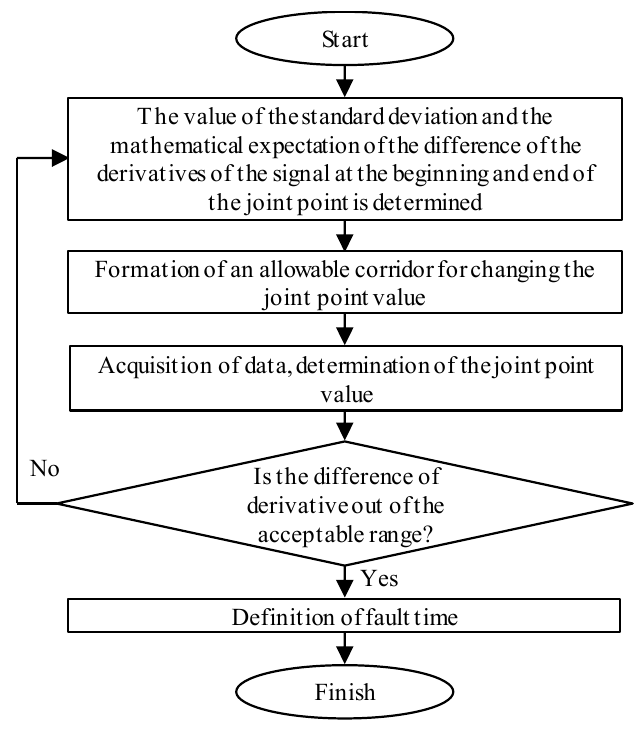
Figure 3. The block diagram of the algorithm 3.